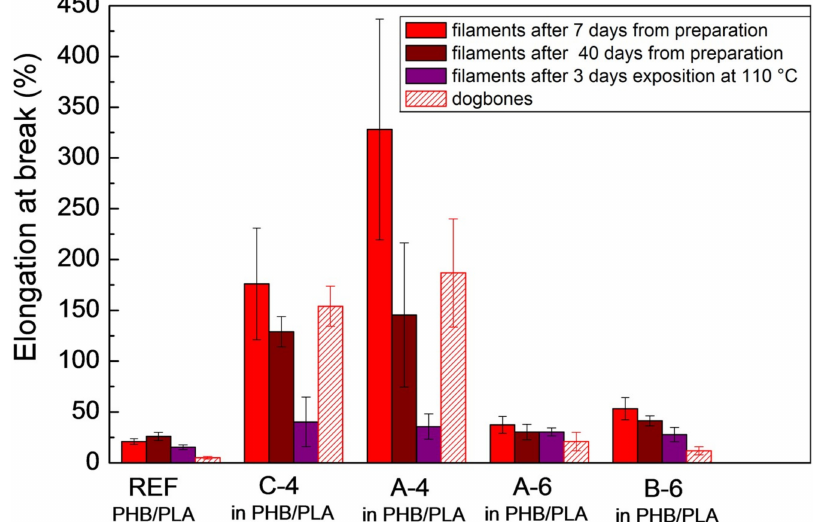
Figure 9. Elongation at break (%) of neat PHB/PLA (reference), PHB/PLA/plasticizers filaments, and 3D printed